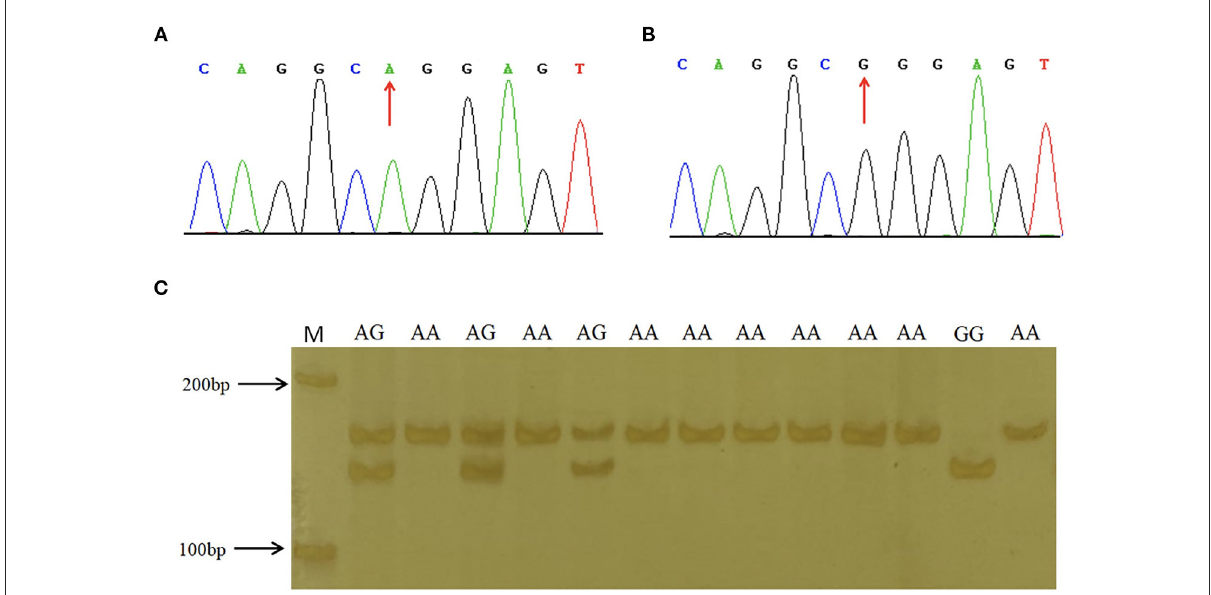
FIGURE2 Sequence and genotyping results of SNP1 in porcine STAT3 promoter region. (A,B) show the sequencing results of SNP1 in the promoter region of porcine STAT3. (C) The enforced MspI PCR-RFLP assay for SNP1. Lane M molecular marker DL